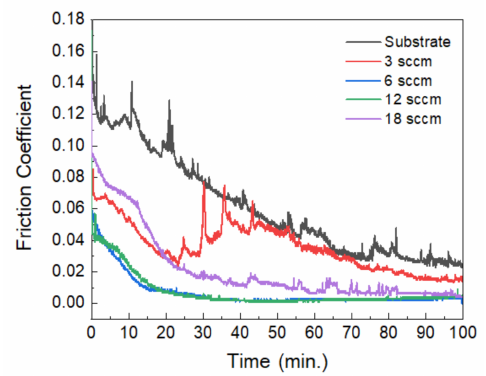
Figure 5. Friction coefficients of the Mo–Cu–Cr–N coatings in the presence of the poly alpha olefin (PAO 8) base